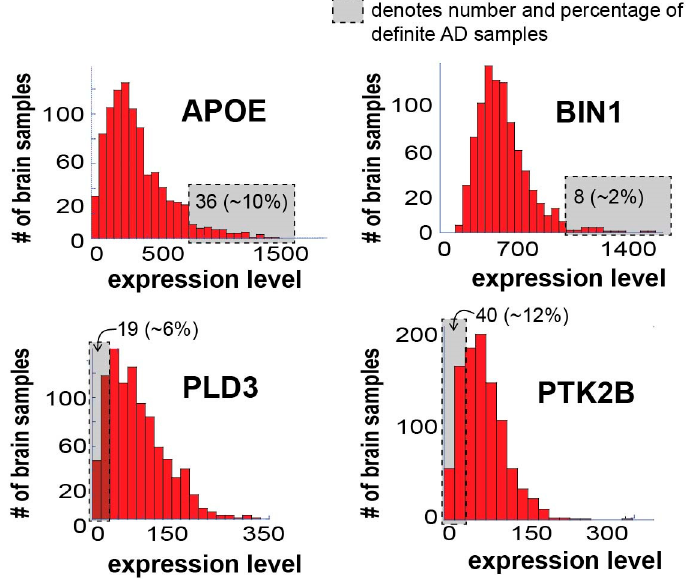
Figure 3. Expression levels of known AD biomarkers vary significantly in different AD patients and most samples do not “behave” as expected in terms of these biomarkers. Four known AD biomarkers were selected for the demonstration of the concept: APOE, BIN1, PLD3, and PTK2B. The figure shows a histogram of expression levels for each of the biomarkers. In each graph, the gray box denotes the number of definite AD samples in the boxed area, including their percentage out of the total definite AD patients in the dataset. Only 36 definite AD samples (10%), significantly overexpress APOE; only 8 definite AD samples (2%) significantly overexpress BIN1; only 19 definite AD samples (6%) demonstrate significant downregulation of PLD3; and only 40 definite AD samples (12%) demonstrate significant downregulation of PTK2B.